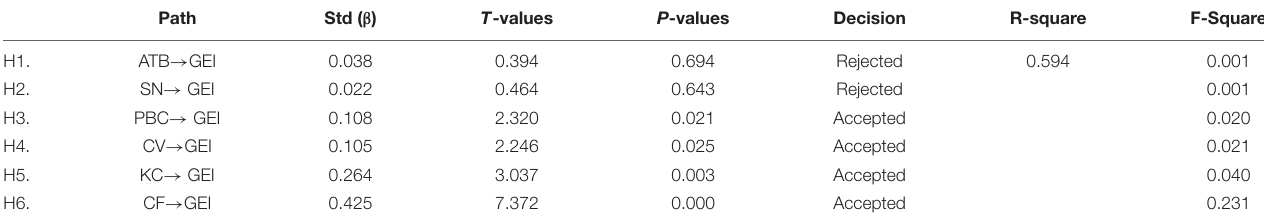
TABLE 5 | Hypotheses testing (bootstrapping 500 samples).